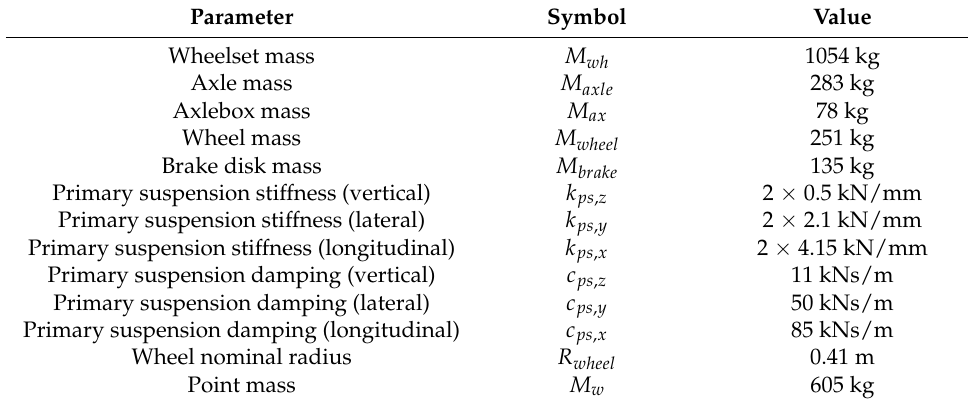
Table 1. Wheelset data and list of symbols. Parameter Symbol Value Wheelset mass M wh 1054 kg Axle mass M axle Axlebox mass Wheel